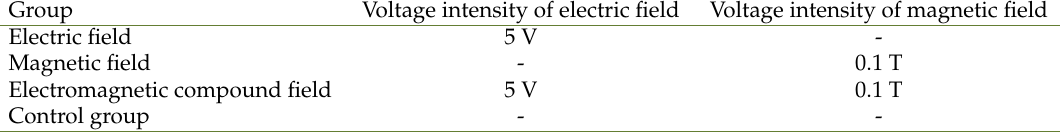
Table 2. Parameters for individual electric field and magnetic field.